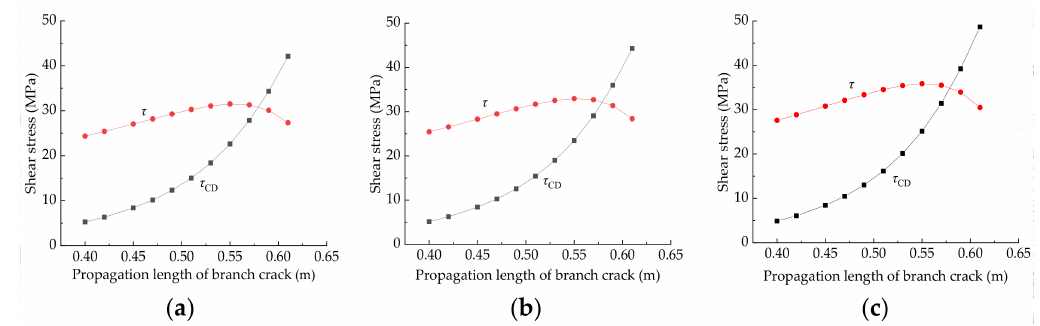
Figure 5. Shear stress and shear strength of rock bridge under di ff erent propagation length of branch crack. ( a ) p = 0.5 MPa; ( b ) p = 1 MPa; ( c ) p = 2